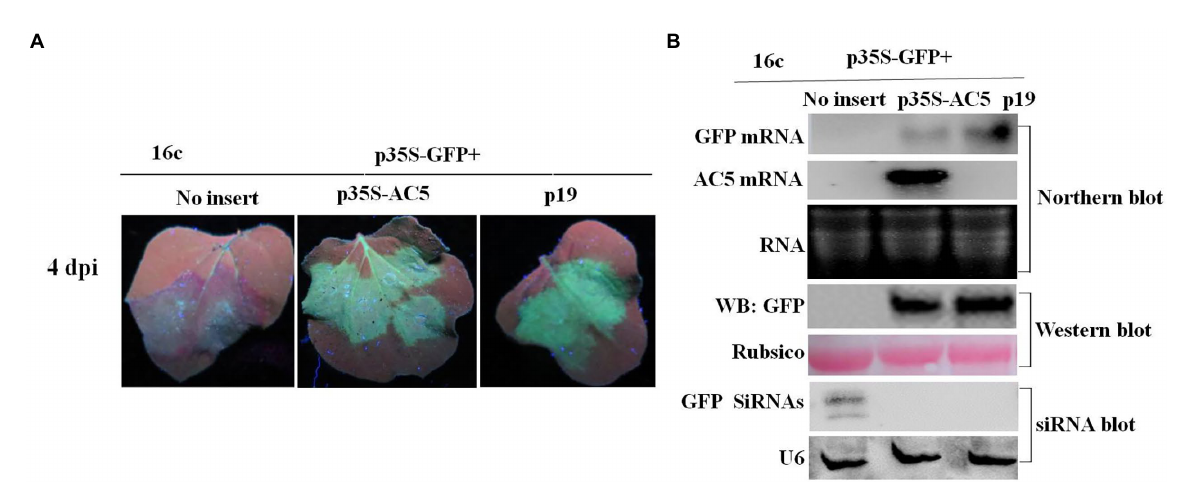
FIGURE 2 GFP silencing in GFP-transgenic N . benthamiana 16c plants. (A) Representative leaf patches or plants were co-infiltrated with A . tumefaciens cultures harboring the p35S-GFP, p35S-AC5, and expression vectors pGreenII 62-SK or the p19 vector. Images were photographed under UV light at 4 dpi. (B) Northern blot of GFP and AC5 mRNA accumulation, western blot of GFP protein accumulation and siRNA blot of GFP siRNA accumulation in Agrobacterium -infiltrated leaf patches as indicated in (A) . SYBR Safe DNA Gel staining of rRNA and Ponceau S staining of the subunit of Rubisco served as loading controls. U6 was the loading control in the siRNA